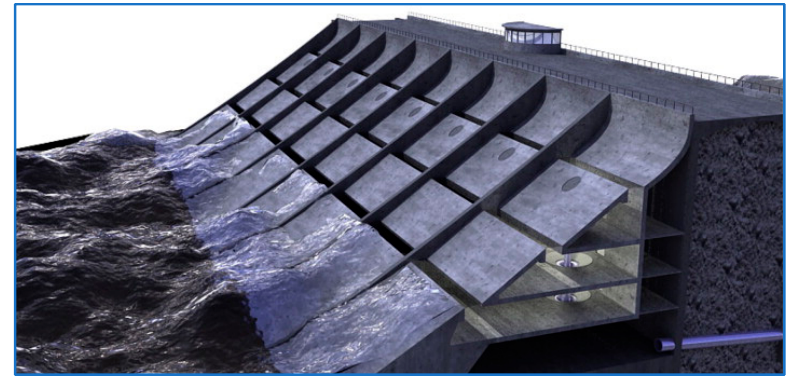
Figure 1. Sea slot-cone generator (SSG) [17].